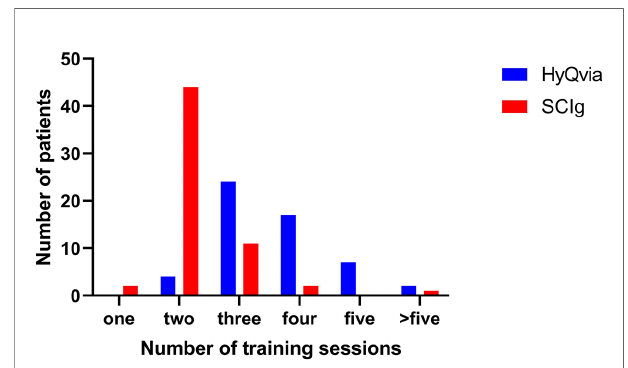
FIGURE 2 | Number of teaching sessions per person for self-administration for conventional SCIg and fSCIg. There was one training session at each visit, and each visit was one day at the